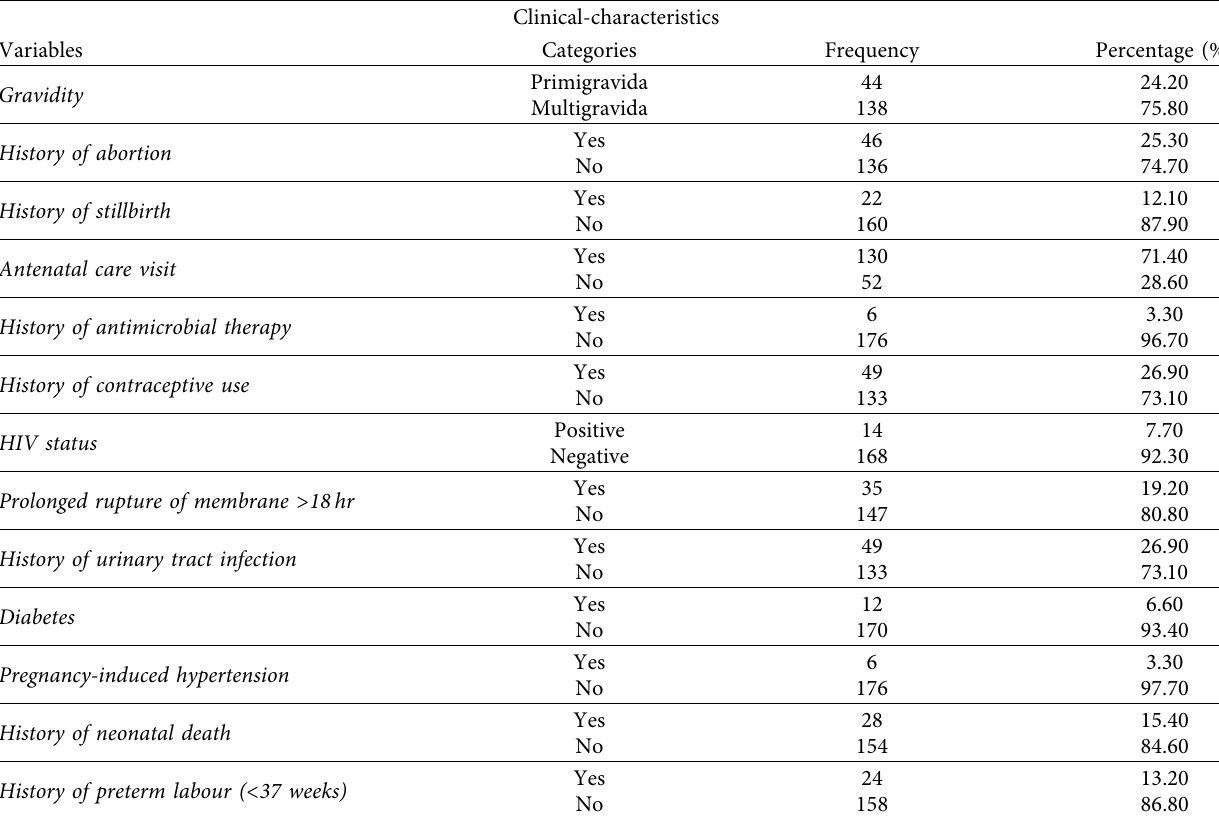
Table 2: Clinical characteristics of the participants at JJUSSHYRH and KGH in Jigjiga city, Southeast Ethiopia, March–May, 2021. Clinical-characteristics